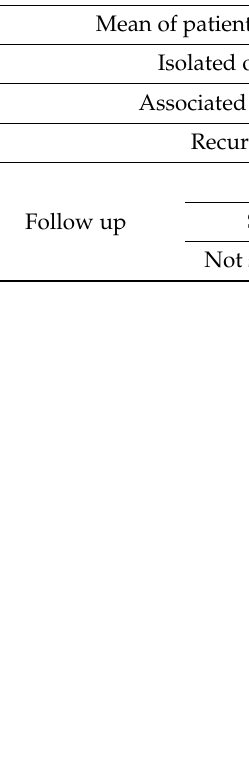
Surgical and Adjuvant Treatment 9 9